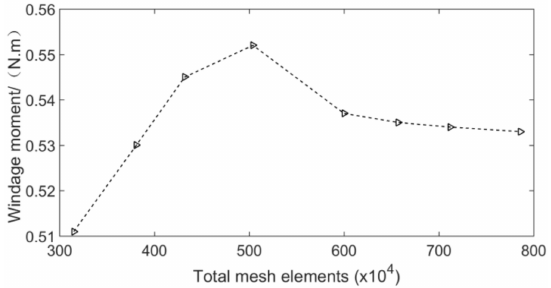
Figure 3. Windage moment against total mesh